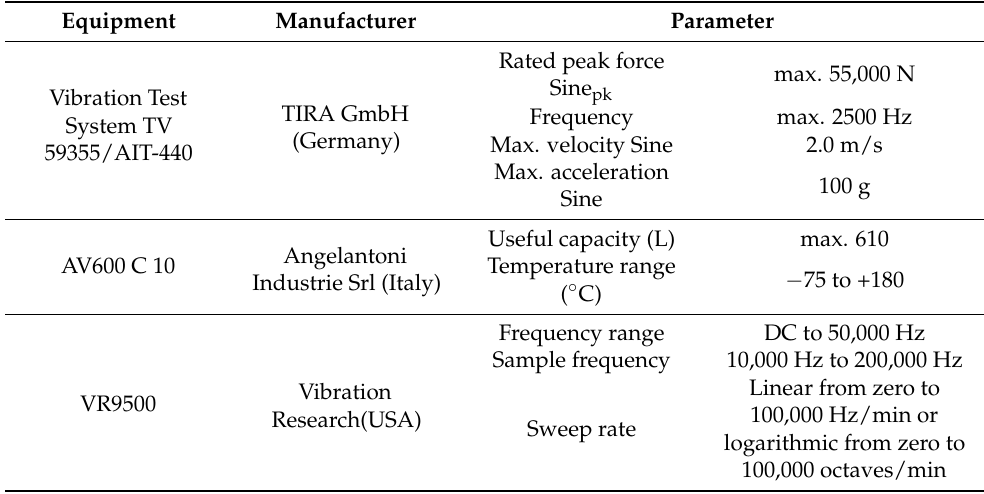
Table 1. Specifications of measurement instruments used in this